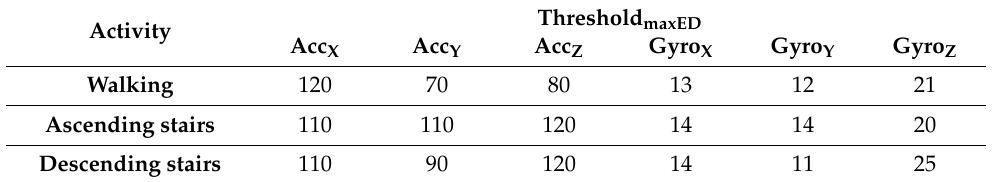
Table 1. Threshold for the maximum acceptable ED for each activity and